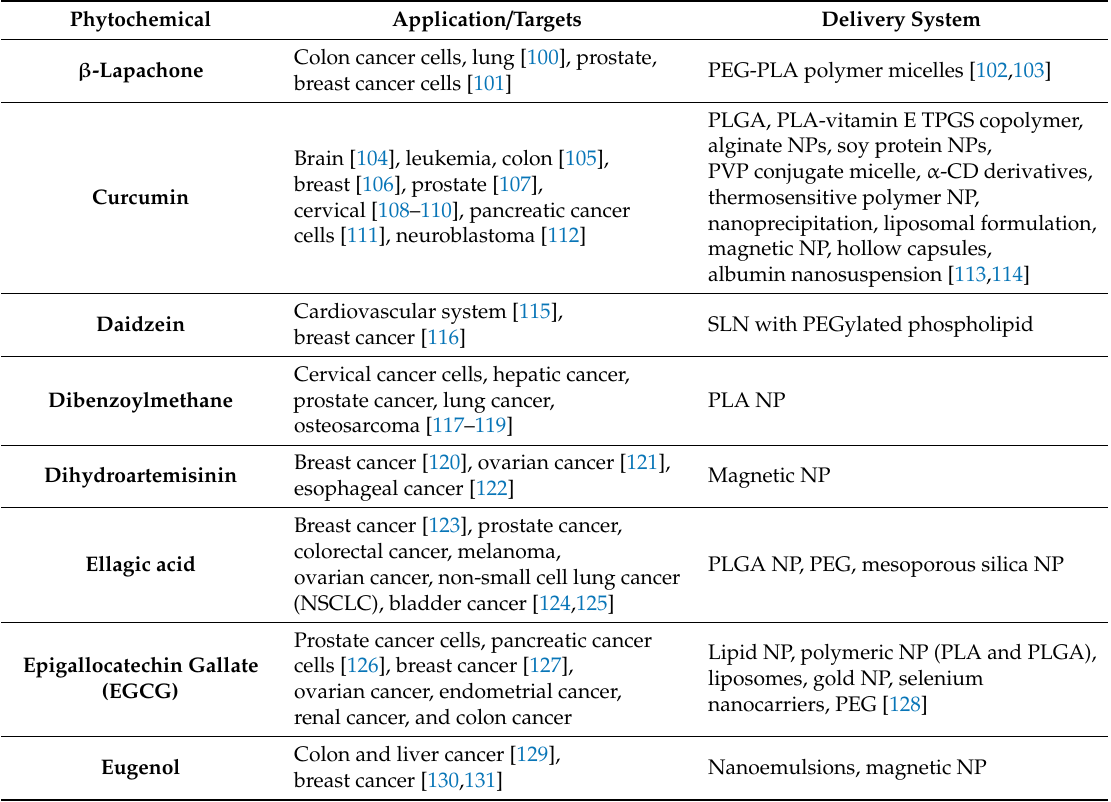
Table 3. Phytochemicals and their application in